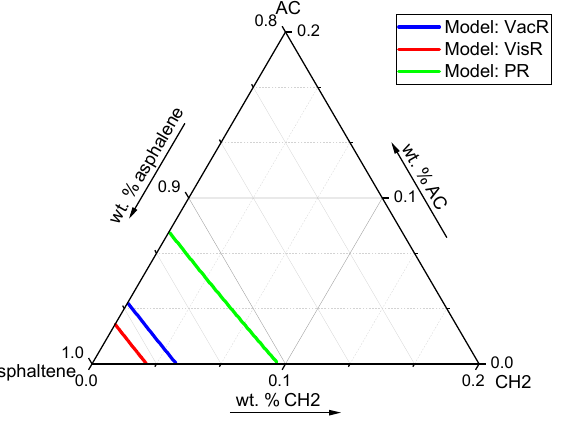
Figure 5. The results of calculating the solubility of the studied asphaltenes in a hypothetical solu- tion of aromatic (AC) and aliphatic (CH 2 ) groups at a temperature of 373 K (the composition is in- dicated in mass fractions).